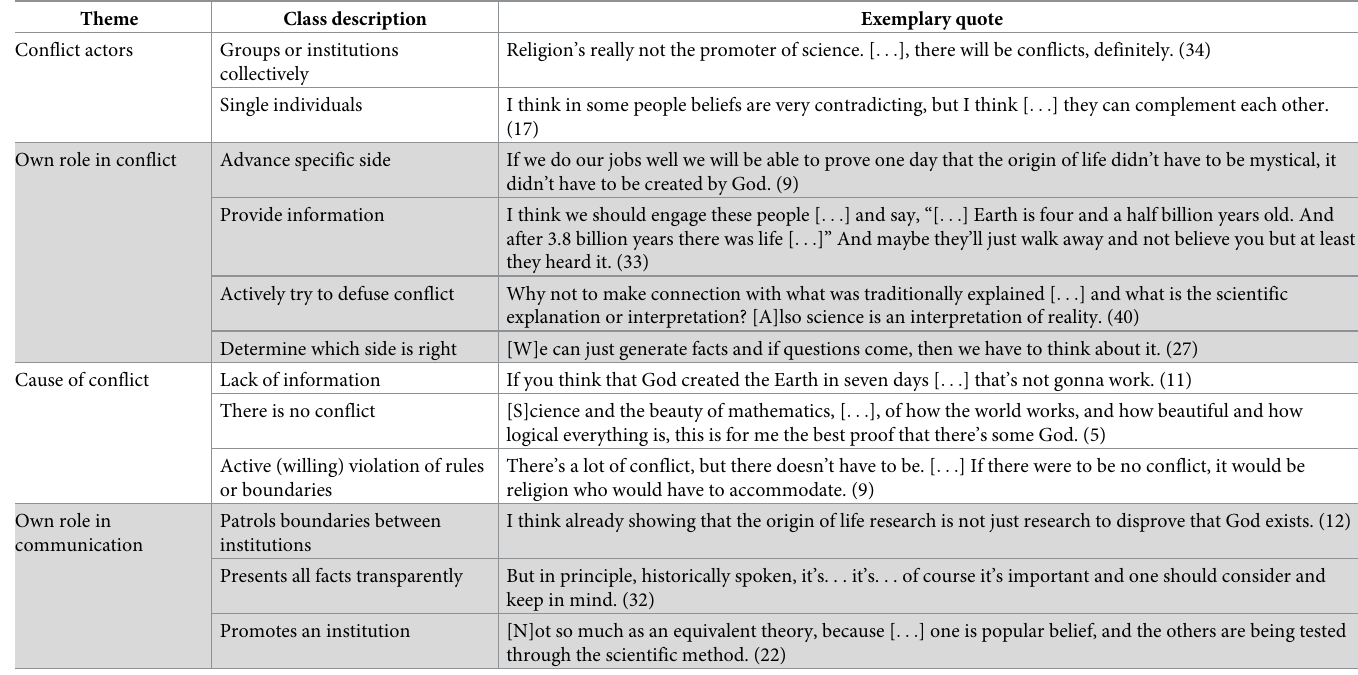
Table 4. Scientists’ views about the science-religion relationship and its communication. Theme